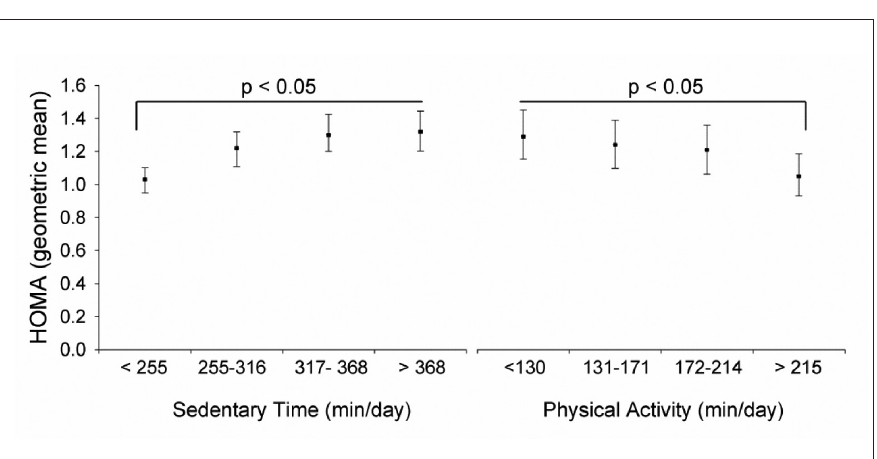
Figure 1. Adjusted geometric means of HOMA-IR stratified by quartiles of time spent sedentary (p for trend = .043) and time spent at MVPA (p for trend = .11) in 9- to 10-year-old Portuguese children (n = 308). Post hoc analyses revealed significant differences (p < .05) between the first and fourth quartile for time spent sedentary and at moderate and vigorous intensity. Data are adjusted for sex, sexual maturity, birth weight, and fat mass. Adapted from (Sardinha et al., 2008